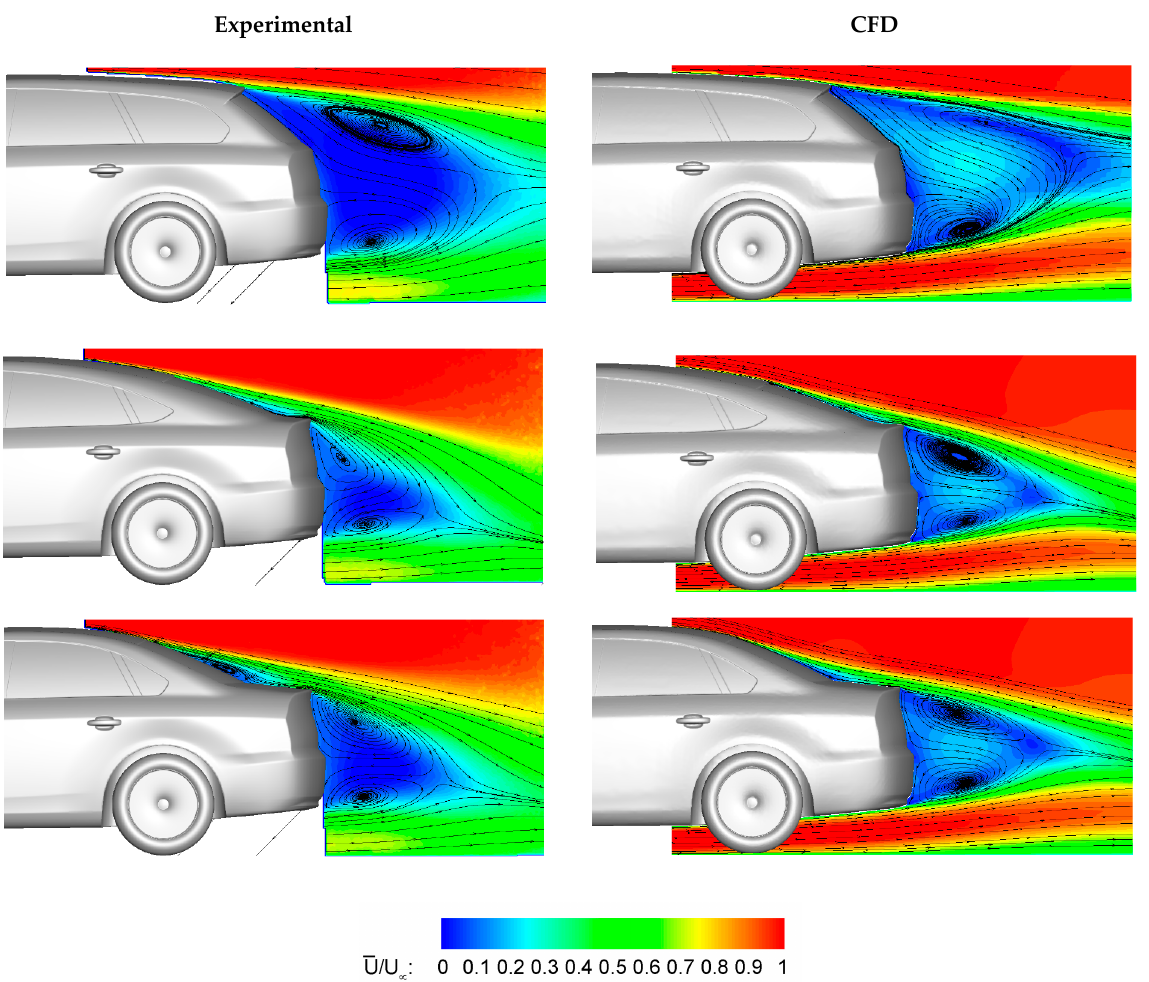
Figure 3. Centreline velocity magnitude plots normalised to free-stream velocity with streamlines in the direction of flow for CFD and experimental results obtained from [18] for the EB, FB, and NB geometries.